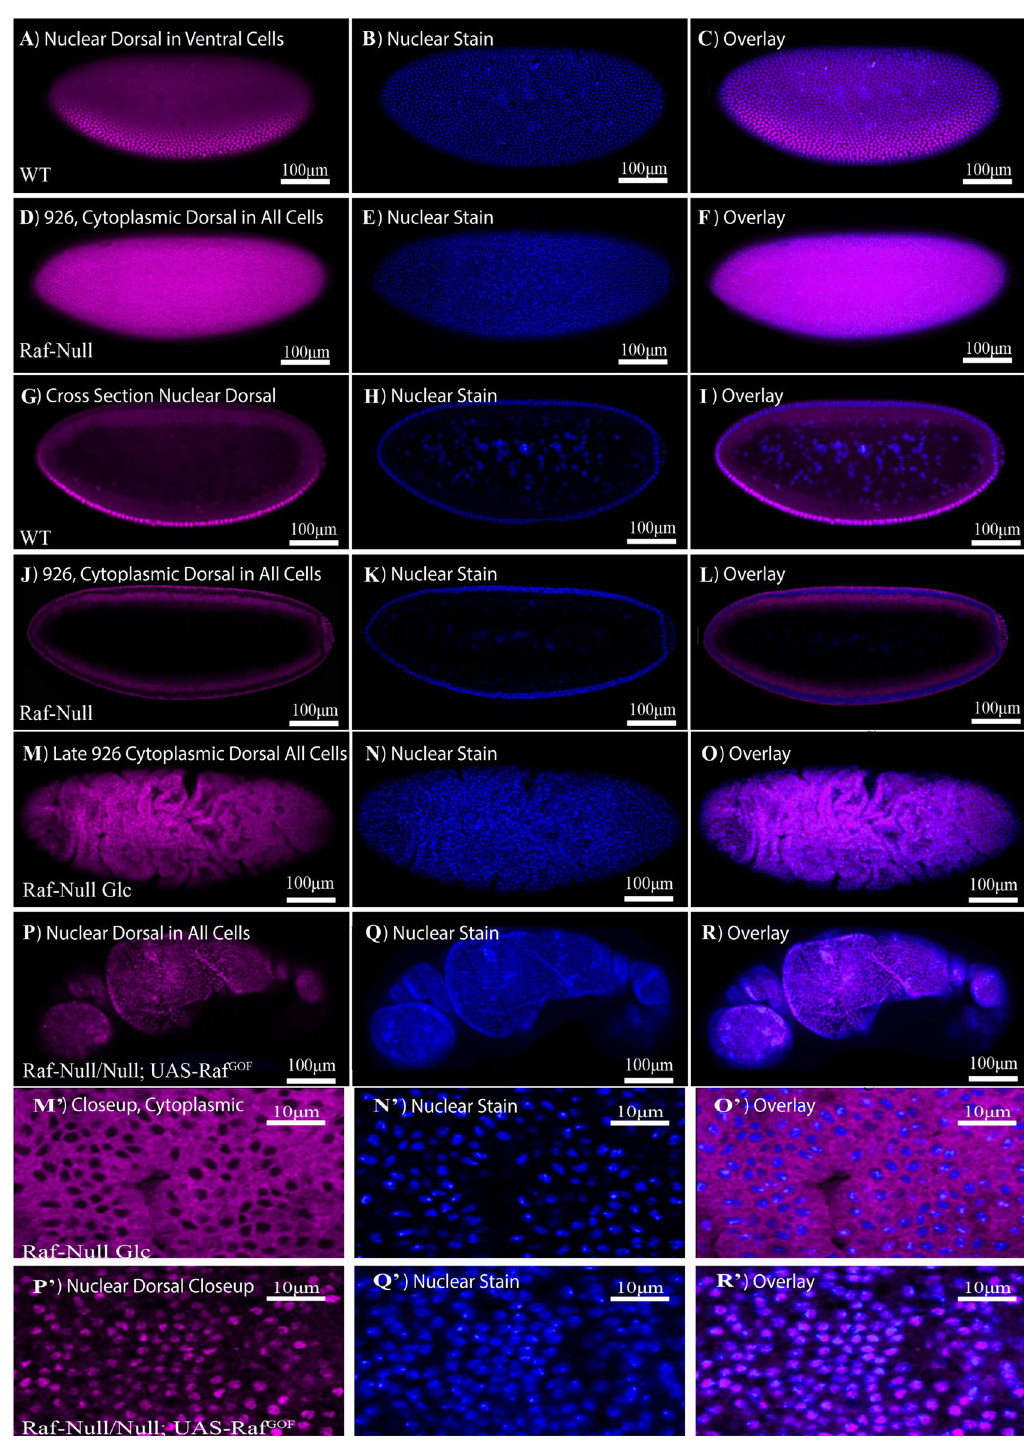
Figure 4. Dorsal nuclear localization in WT, Raf 926 embryo and Raf 926 embryo expressing Raf GOF . Surface view of the lateral orientation of the wildtype embryo ( A ) undergoing cellularization with a nuclear Dorsal gradient along the dorsal–ventral axis, ( B ) shows the corresponding nuclear stain and ( C ) a merged image. Surface view of the lateral orientation of the Raf 926 embryo ( D ) undergoing cellularization with complete exclusion of Dorsal from the nuclei. ( E ) The corresponding nuclear stain and ( F ) a merged image of both. Cross-sectional view of the lateral orientation of the ( G ) wildtype embryo showing the gradient nuclear localization of Dorsal along the dorsal–ventral axis, ( H ) shows the corresponding nuclear stain and ( I ) a merged image of both. Cross-sectional view of Raf 926 embryo ( J ) showing the complete exclusion of Dorsal from the nucleus, ( K ) showing the corresponding nuclear stain and ( L ) a merged image of both. Surface view of ( M , M ′ ) Raf 926 later stage embryo showing abnormality in development after cellularization and exclusion of Dorsal from the nucleus. The corresponding nuclear stain ( N , N ′ ) and merged images ( O , O ′ ). ( P , P ′ ) Raf 926 embryo expressing Raf GOF showing dorsal nuclear localization. ( Q , Q ′ ) shows the corresponding nuclear stain and ( R , R ′ ) the merged